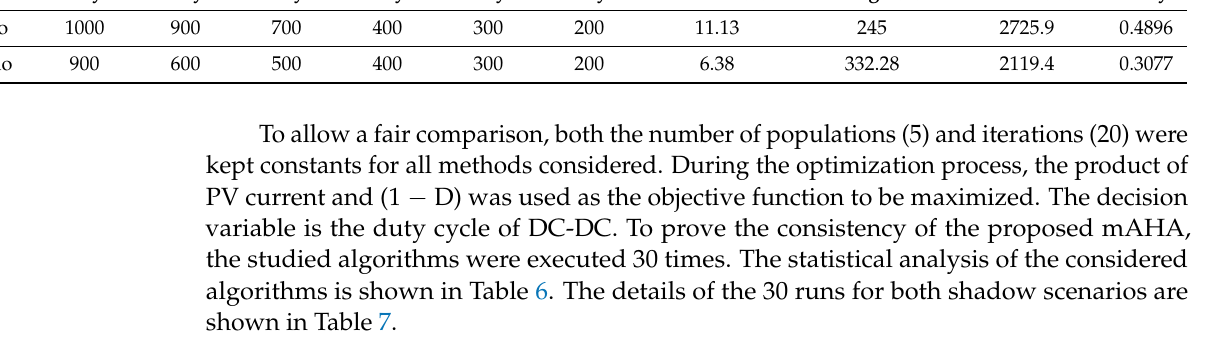
Table 6. Statistical assessments of considered algorithms for both shadow scenarios.